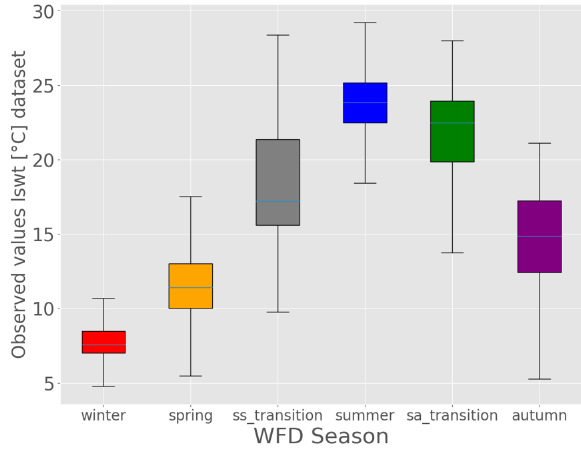
Figure 12. Boxplot per season- LSWT (three lakes).